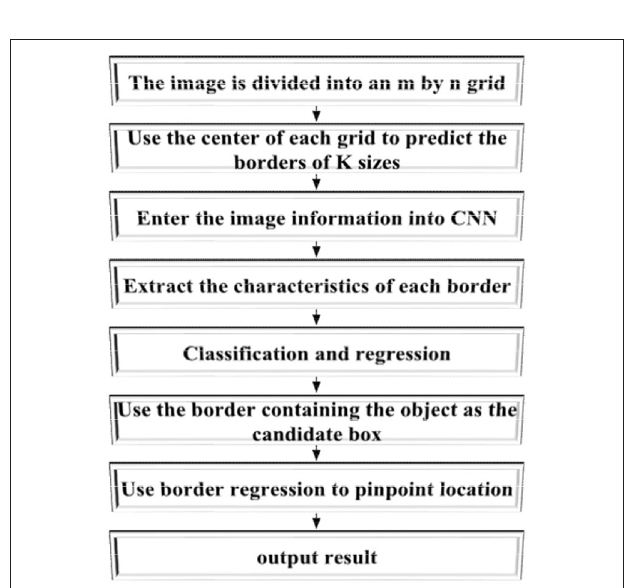
FIGURE 3 | Bounding box selection by Region Proposal Network (RPN) method.